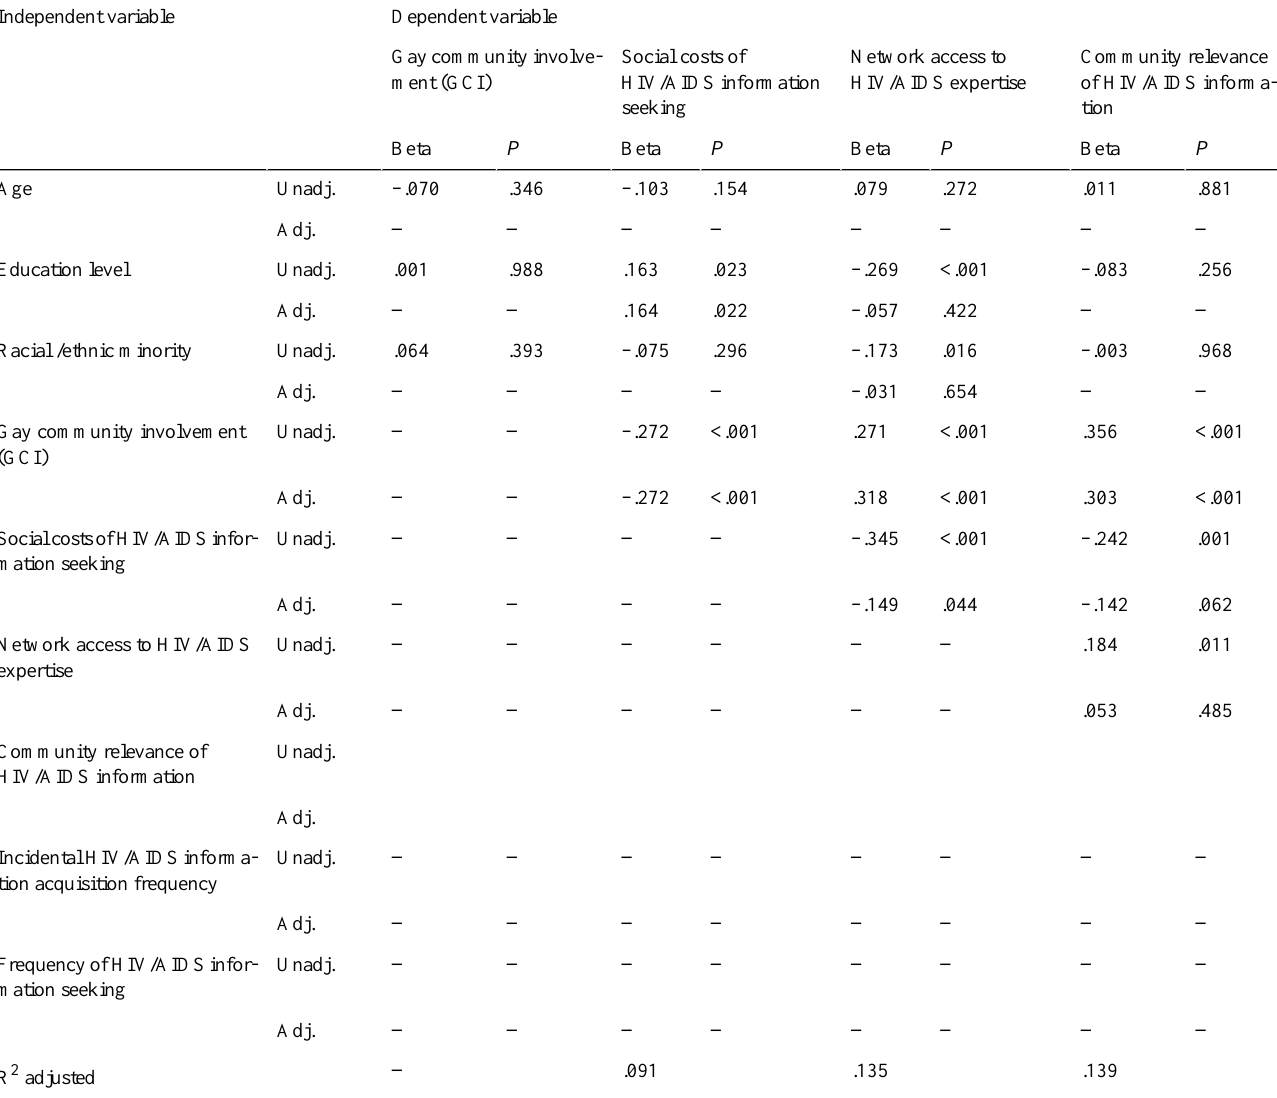
Table 4. Linear regressions for community-related